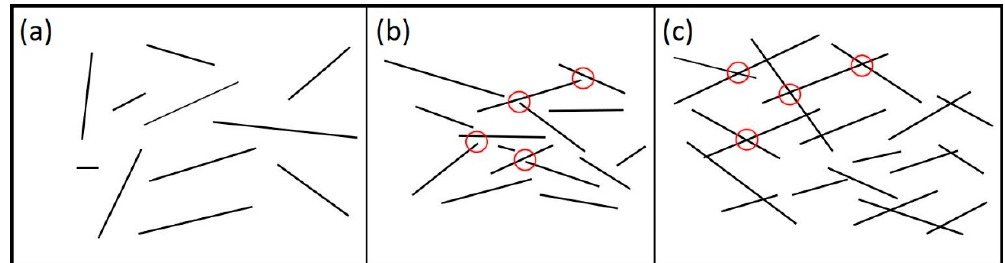
Figure 7. Schematic of percolation mechanisms. ( a ) CNT amount below the percolation threshold ( b ) CNT amount above the electrical but below the mechanical percolation threshold. Circles show examples of places where electron tunneling may occur due to a thin layer of insulating polymer between nanotubes. ( c ) CNT amount above the mechanical percolation threshold. Circles show examples of places where physical contacts of nanotubes are visible. Nanotube bonds result in a long carbon fiber, which improves the mechanical properties of the composite.